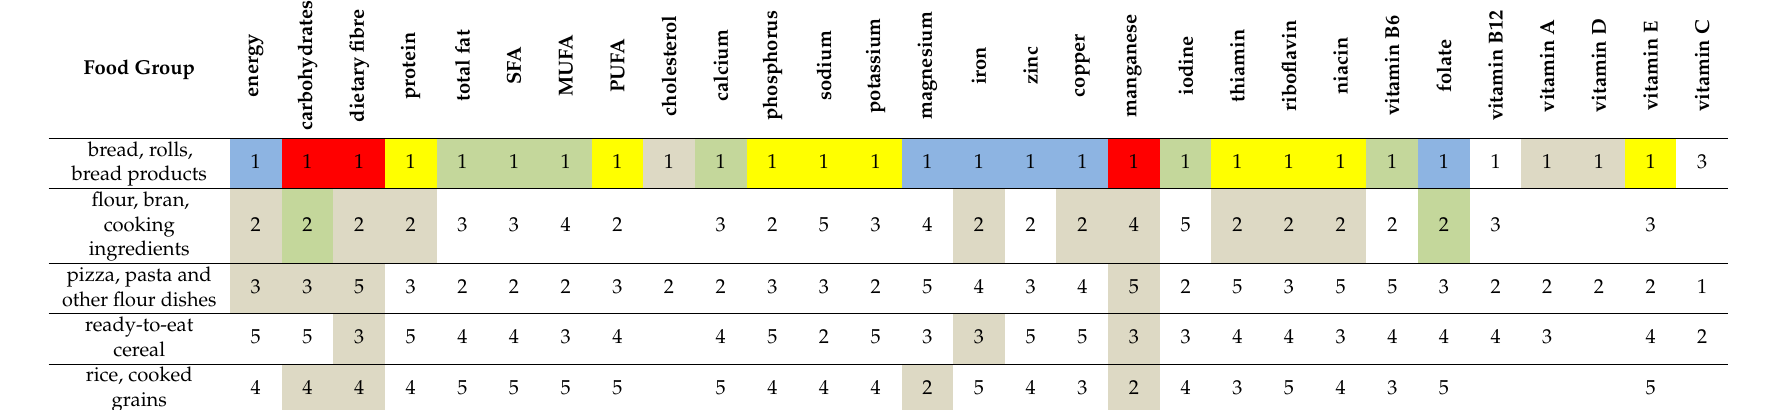
Food Table 7. Rankings 1/ of main cereal groups as contributors of energy and nutrients 2/ in the average Polish diet.